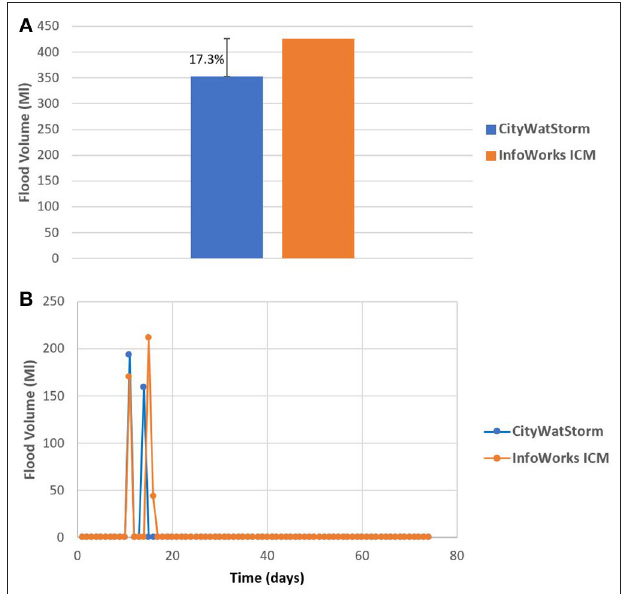
FIGURE 4 | CityWatStorm vs InfoWorks ICM. (A) Total flood volume comparison. (B) Flood volume timeseries comparison.